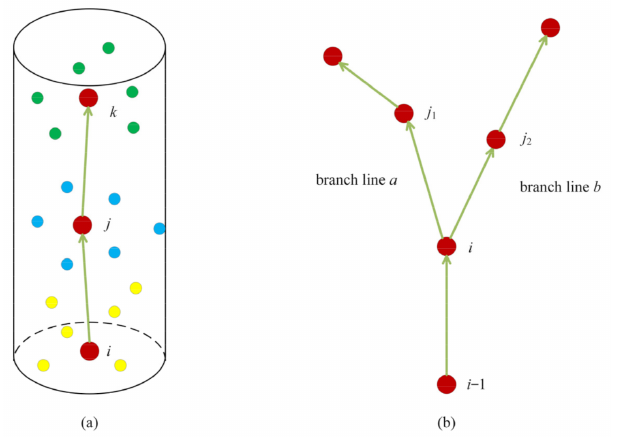
Figure 3. Calculation of the dominant direction of the initial skeleton point. ( a ) Single child node; ( b ) Multi child